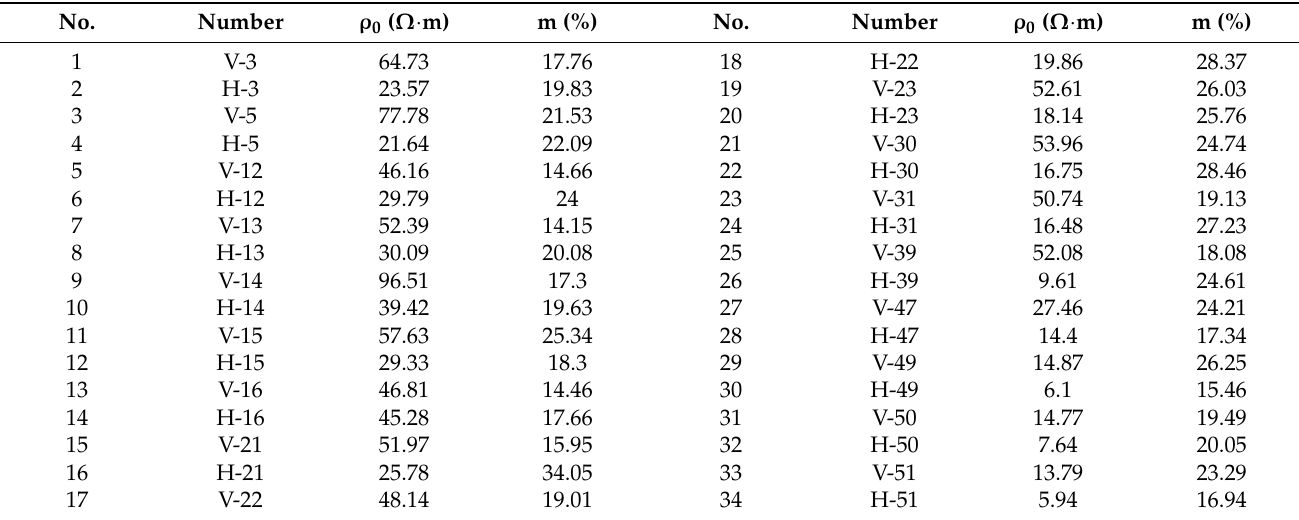
Figure 9 is the intersection diagram of zero-frequency resistivity, porosity and per- meability at normal temperature and pressure. The resistivity decreases with the increase of porosity, but the shale porosity in H and V directions shows little difference. The hor- izontal permeability is higher than the vertical permeability, and the resistivity in the horizontal direction is lower than 40 Ω · m as a whole. In the zero-frequency resistivity and permeability diagram, the V direction data are in the upper left corner, with an average value of zero-frequency resistivity of 127.25 Ω · m and an average value of permeability of 0.019 × 10 − 3 µ m 2 . H direction data are in the lower right corner, with an average zero- frequency resistivity of 22.21 Ω · m and an average permeability of 1.099 × 10 − 3 µ m 2 . Generally, the average resistivity decreases with the increase in permeability. Therefore, the resistivity and permeability parameters of shale have strong directionality, which cannot be ignored in the process of reservoir